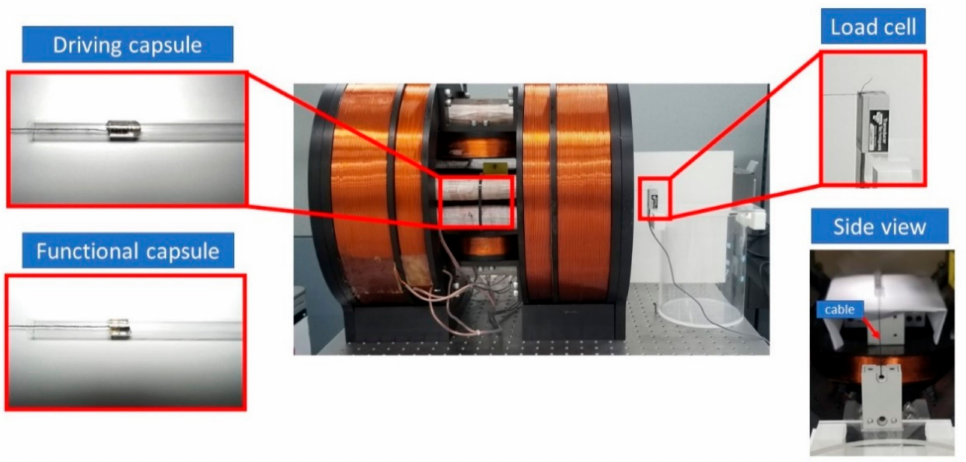
Figure 8. Experimental setup for measuring propulsion